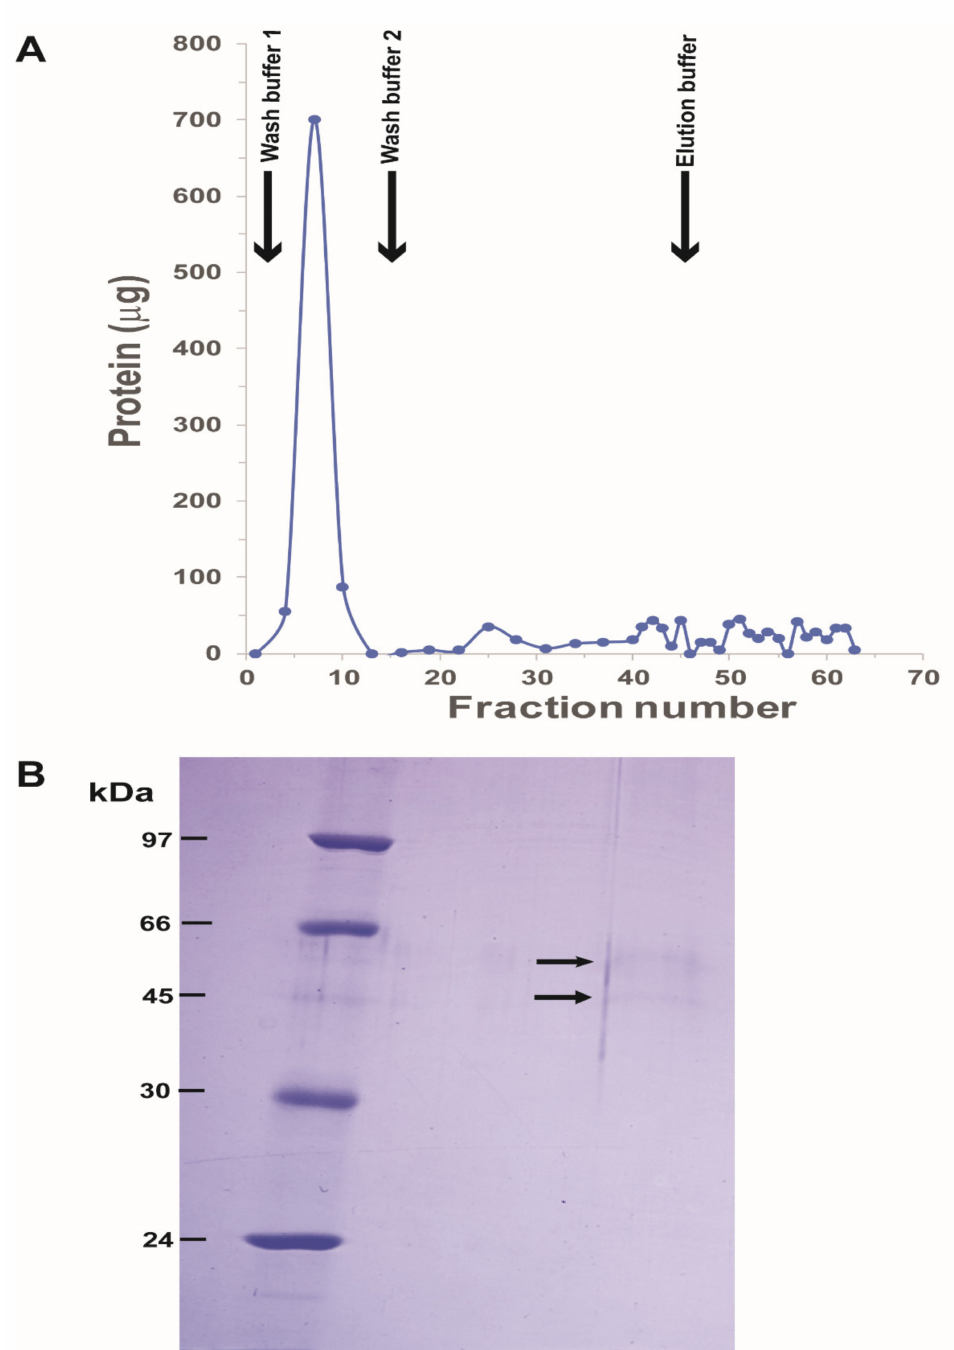
Figure 1. ( A ) Purification of His 6 -TMOF cross linked to solubilized Ae. aegypti TMOF receptor by Ni affinity chromatography. The cross-linked proteins to His 6 -TMOF were adsorbed to a Ni affinity column, the column was washed with buffer 1 (PBS, 0.15 M NaCl, 0.5% CHAPS) (15 mL) followed with wash buffer 2 (wash buffer 1 with 20 mM imidazole) (30 mL) and the crossed linked proteins to TMOF complex were eluted with 20 mL of elution buffer (buffer 1 containing 250 mM imidazole). Fractions (1 mL) were collected and analyzed for protein. Fractions (51–56 and 58–61) were collected and dried by speed vac and rehydrated with SDS sample buffer. The purification procedure was repeated three times. ( B ) SDS PAGE of the rehydrated His 6 -TMOF cross linked proteins after the Ni affinity chromatography. Protein standards (M r 97 kDa to 24 kDa) were run in the left lane and TMOF cross linked membrane proteins complex in the right lane. After staining the gel, two faint protein bands were detected M r 55 kDa and M r 45 kDa (arrows). The bands were cut and analyzed by MS/MS. The SDS-PAGE was repeated three times showing the same faint